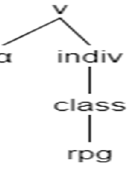
Figure 6. Geometry of v.